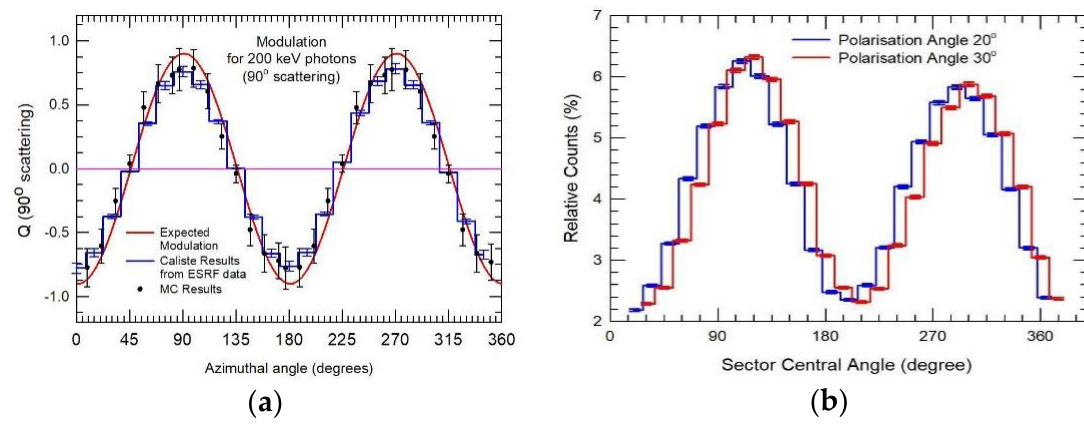
Figure 8b reports the sensitivity in the measurable polarization fraction of the CZT Caliste module at 200 keV as compared with IMARAD PolCA results at 400 keV. This graph clearly shows that in the PolCA case the minimum detectable fraction is about 1.5 times larger than in the case of the Caliste detector (~38% with respect to ~27%). We chose to compare the IMARAD PolCA detector with respect to the Caliste module, using higher energies to take, at least partially, into account the effect of the difference in pixel sizes and energy thresholds between the two systems.